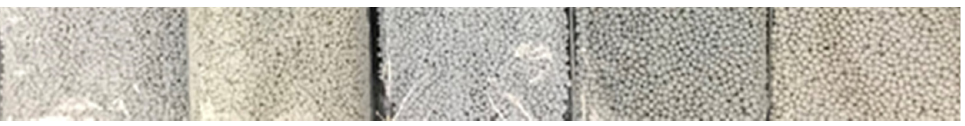
Figure 15. PCR preforms and bottles (image courtesy of Amcor).